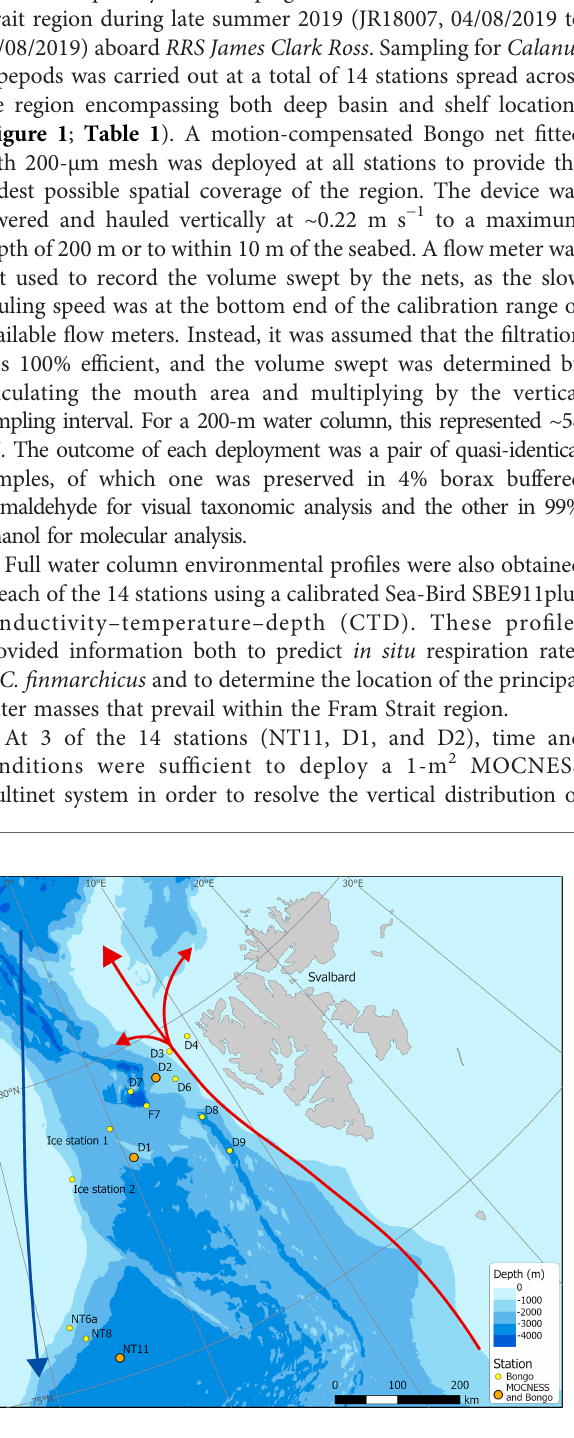
FIGURE 1 | Sampling station locations in Fram Strait carried out during cruise JR18007 (August 2019). (Red – northward fl owing Atlantic Water; Blue – southward fl owing Polar Surface